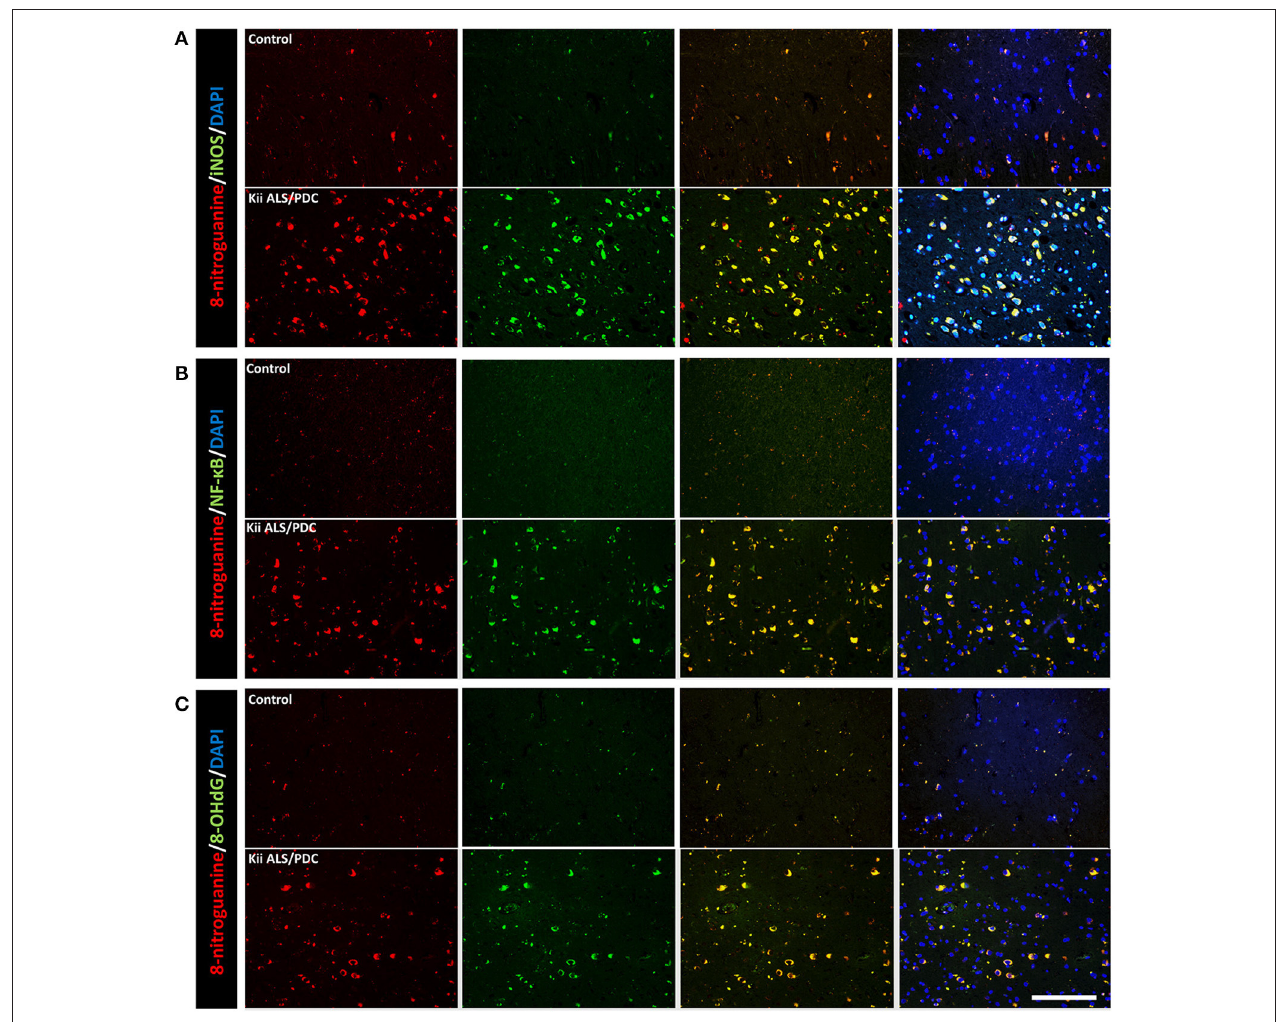
FIGURE 2 | Double immunofluorescence staining in the hippocampus of control and Kii ALS/PDC patients. (A) Anti-8-NG antibody and anti-OHdG antibody. (B) Anti-8-NG antibody and anti-NF- κ B antibody. (C) Anti-8-NG antibody and anti- iNOS antibody (all images × 200, scale bar represents 50 µ m).